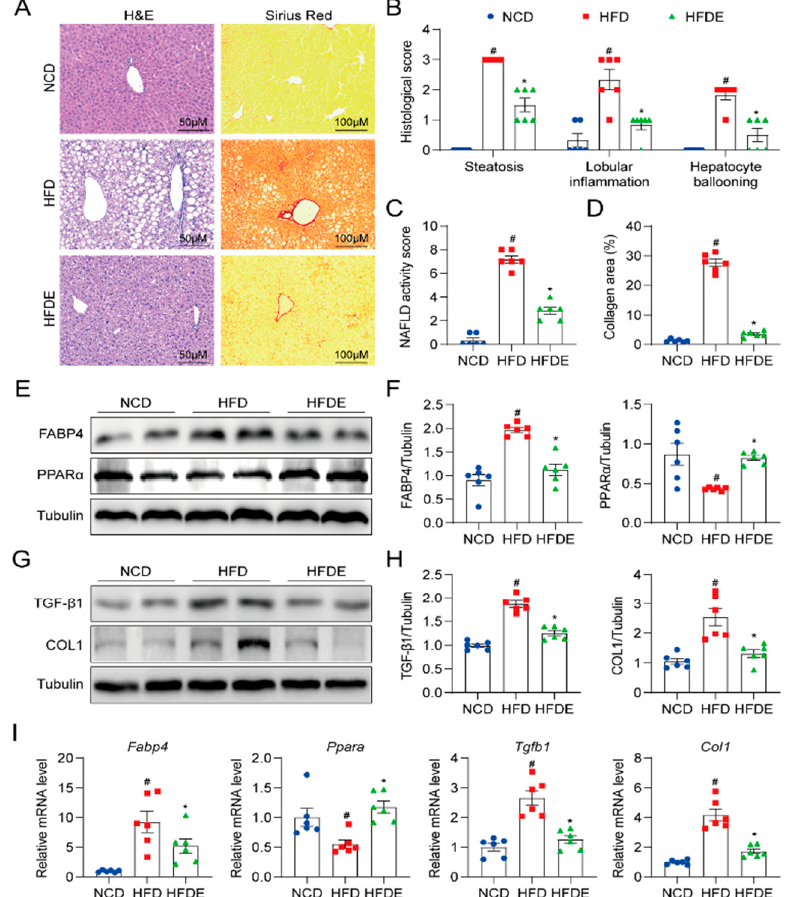
Figure 2. Exercise decreases steatosis and fibrosis in mouse livers. ( A ) Representative images of liver sections stained by H&E (200 × , left panel) and Sirius Red (100 × , right panel). ( B ) Histological scores of steatosis, lobular inflammation, and hepatocyte ballooning in H&E-stained livers. ( C ) NAFLD activity score was calculated by the histological score of steatosis, lobular inflammation, and hepa- tocyte ballooning. ( D ) The collagen areas seen by Sirius Red staining. ( E , F ) Protein levels of lipid metabolism markers FABP4 and PPAR α in mouse liver tissues. Tubulin was used as the loading control. ( G , H ) Protein levels of fibrosis markers TGF- β 1 and COL1 in mouse liver tissues. Tubulin was used as the loading control. ( I ) Relative mRNA levels of Fabp4, Ppara, Tgfb1, and Col1 in mouse liver tissues. The data are presented as the mean ± SEM, n = 6 per group. # p < 0.05 vs. NCD group; * p < 0.05 vs. HFD